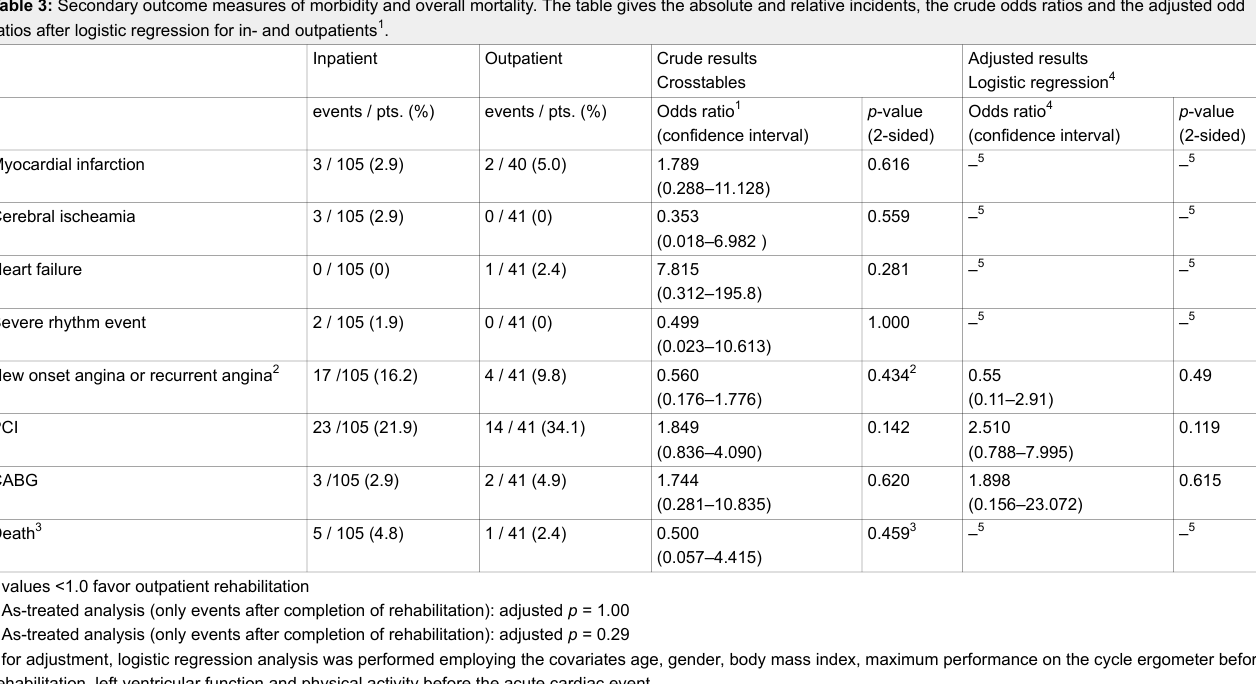
Table 3: Secondary outcome measures of morbidity and overall mortality. The table gives the absolute and relative incidents, the crude odds ratios and the adjusted odd ratios after logistic regression for in- and outpatients 1